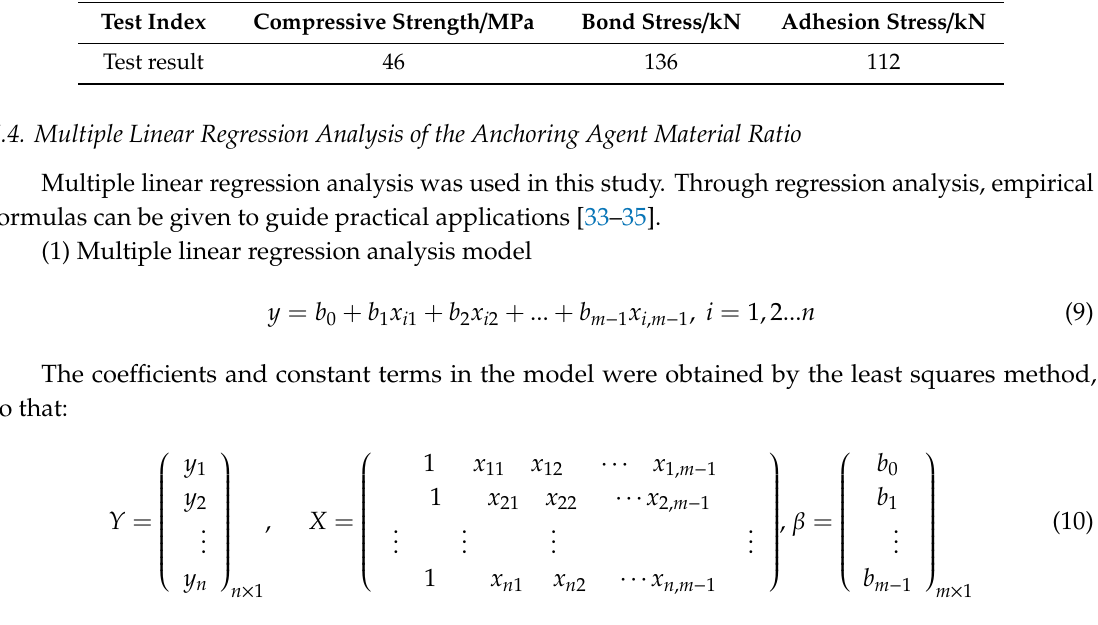
Table 11. Test results of mechanical indexes under optimal level